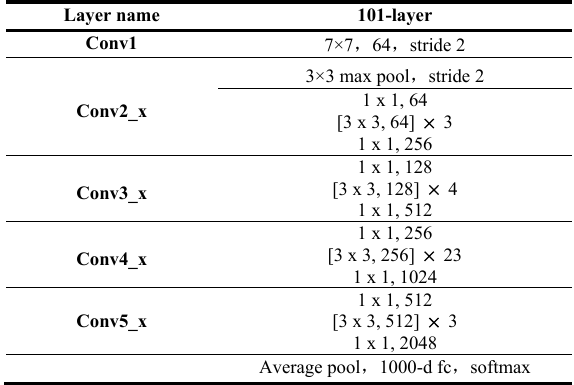
Table. 1 ResNet101 network structure